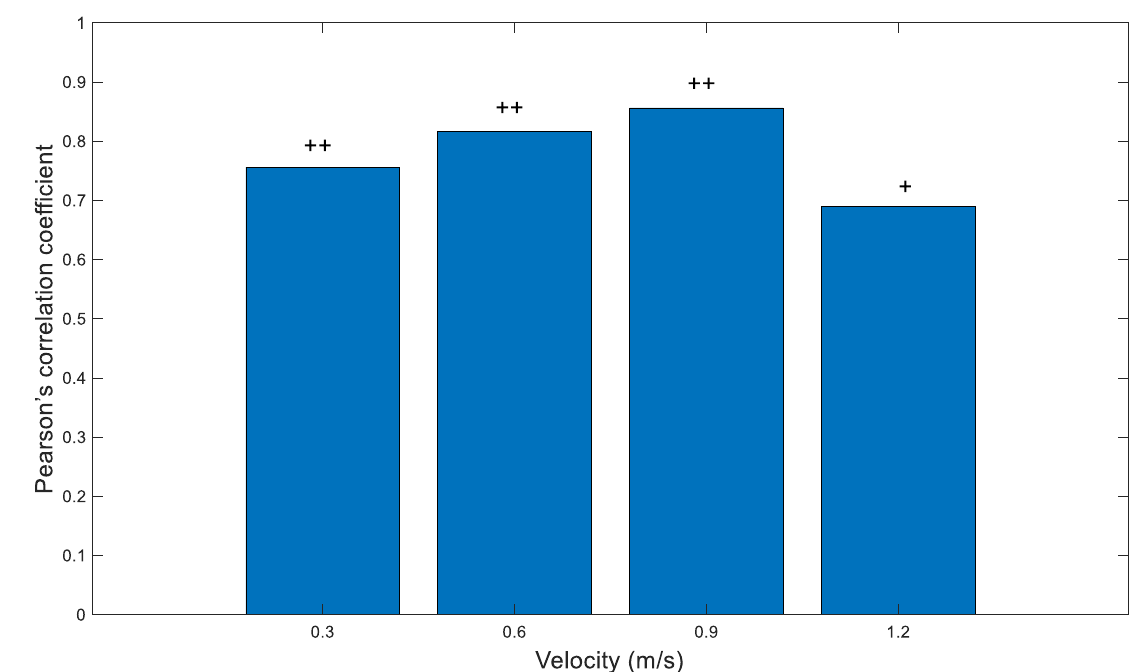
Figure 8. Pearson’s correlation between the number of right limb EMG peaks of medial gastrocnemius activity between two sessions of overground walking. Overall results indicate moderate to good level of agreement. All correlations were significant at p < 0.05. Correlation: + = moderate, ++ = high.